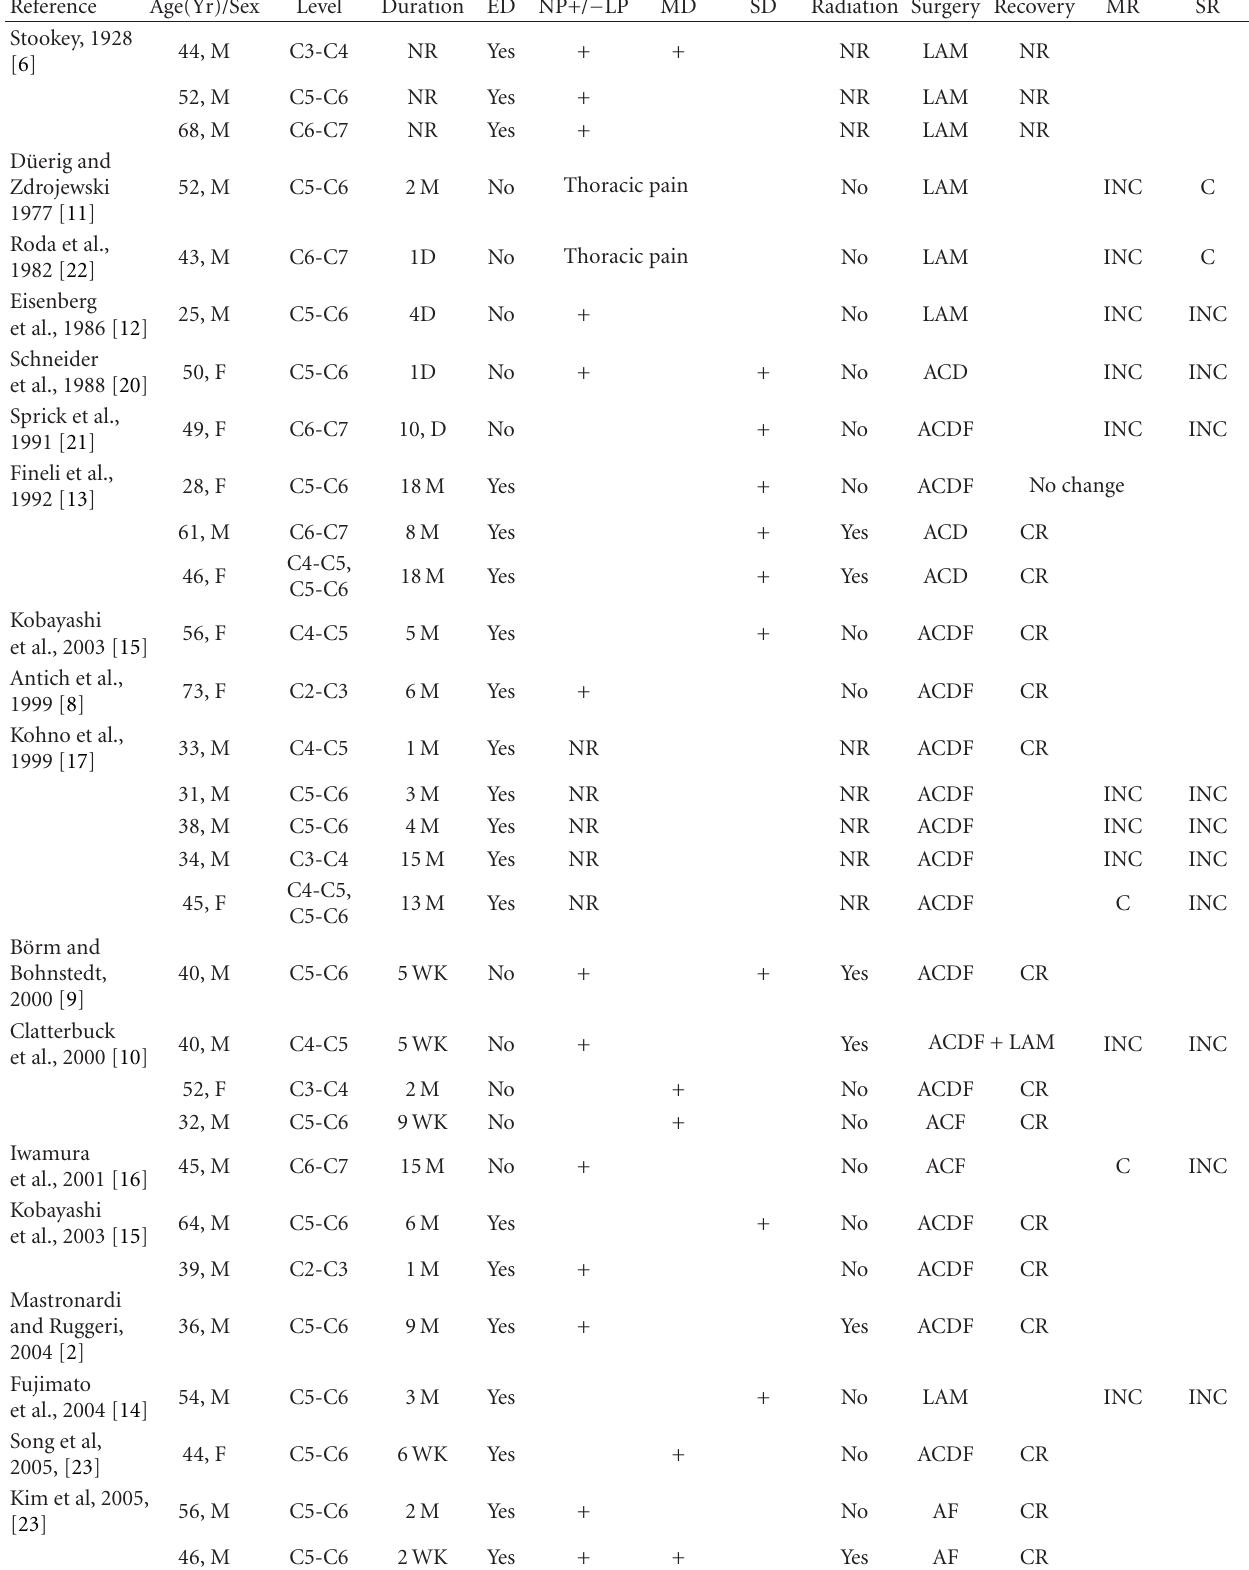
Table 1: Details of the cases reported in the